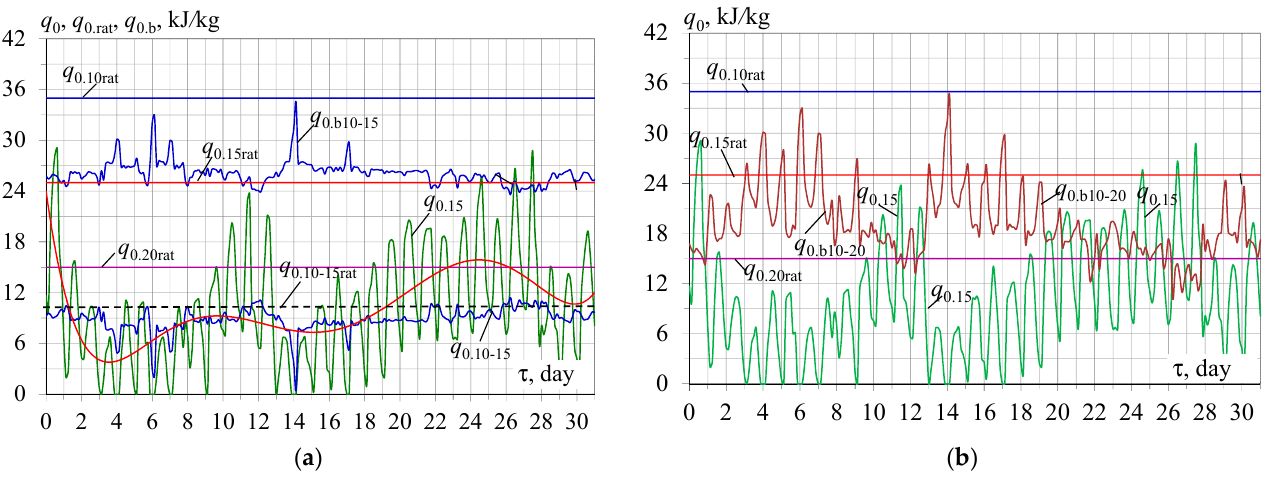
Figure 2. Current values of specific cooling capacities q 0.15 needed for cooling ambient air to t a 2 = 15 °C; rational design cooling capacities q 0.10rat , q 0.15rat , and q 0.20rat for t a 2 = 10, 15, and 20 °C, respectively; current cooling capacities q 0.10-15 for cooling air from t a 2 = 15 to 10 °C and current residual boost part q 0.b10-15 available for cooling air t a 2 = 15 °C ( a ) and boost part q 0.b10-20 available for cooling air to t a 2 = 20 °C ( b ).